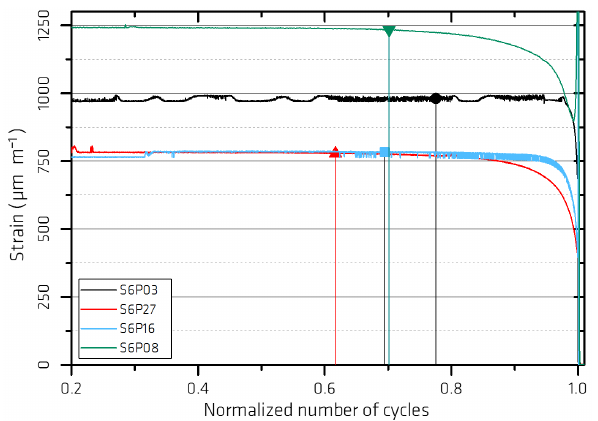
Figure 10. Strain evolution of four specimens (welt joint), each with a marked cycle of crack detection by luminescence. The num- ber of cycles was normalized with fracture cycle number on the horizontal axis and strain amplitude on the vertical